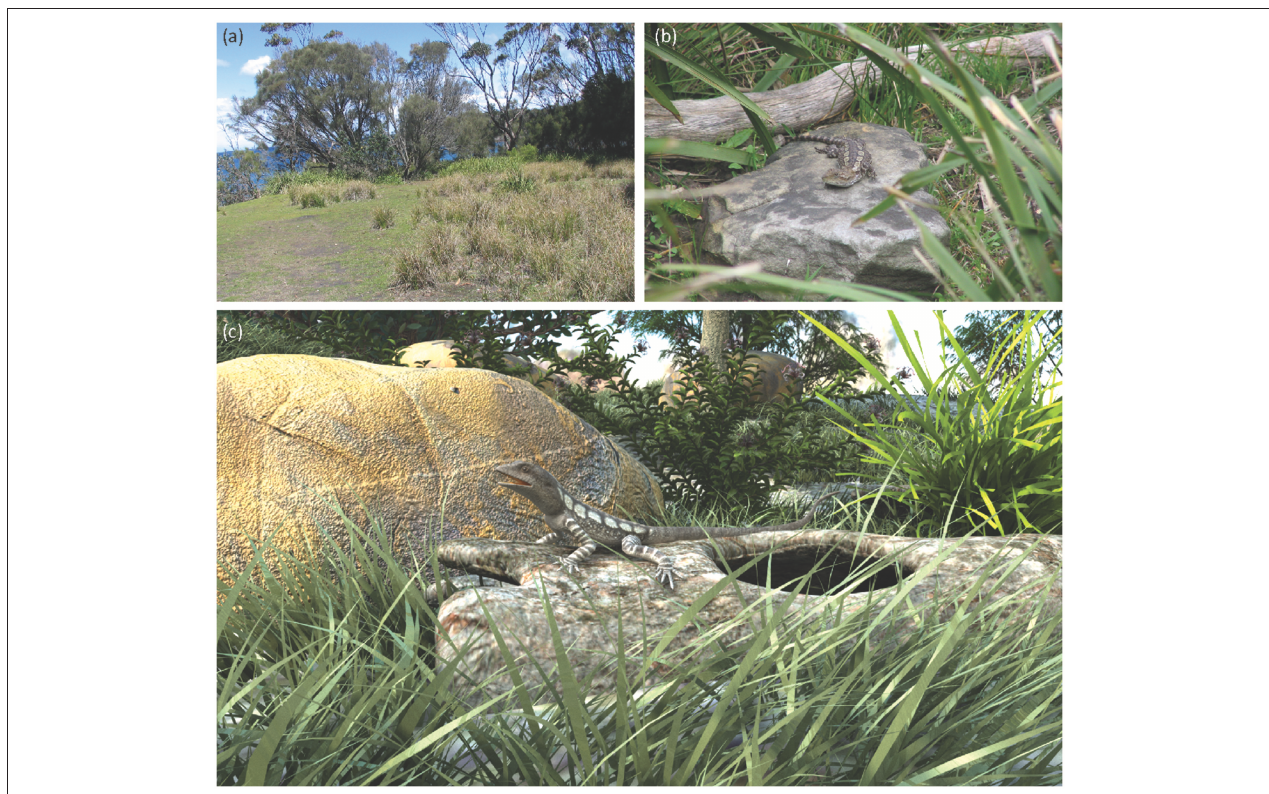
FIGURE 1 | (a) Representative habitat of Jacky dragons Amphibolurus muricatus along the south-east coast of Australia, and (b) a basking adult Jacky dragon. (c) Rendered frame of the 3D animation environment showing the simulated habitat and lizard.